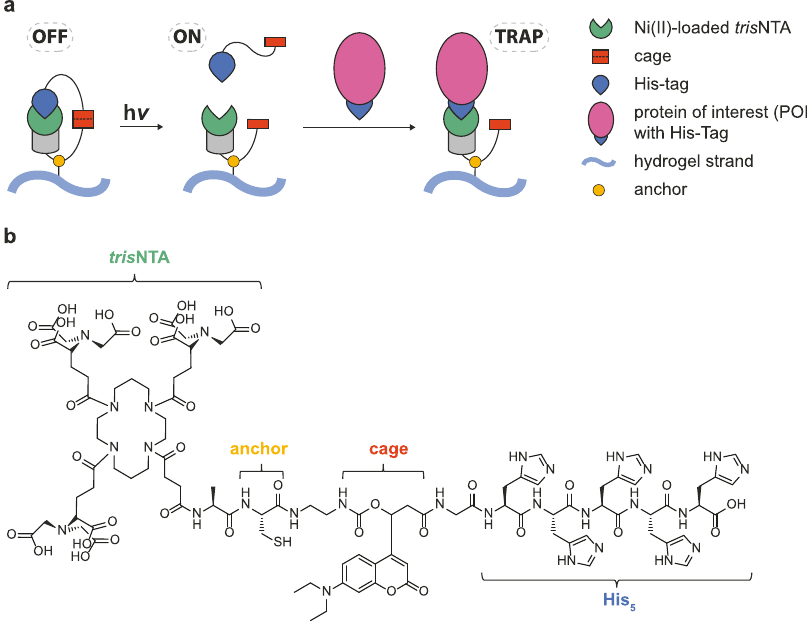
Fig. 1 Concept and chemical structure of a two-photon activatable tris NTA interaction molecule. a Schematic illustration of the autoinhibition (OFF) and light-activation (ON) of TPA- tris NTA with subsequent trapping of His-tagged POIs. b Design of TPA- tris NTA. The interaction molecule consists of the tris NTA head group and an intramolecular His C -terminus. For 2P photocleavage, a DEAC-based β -amino acid is strategically incorporated 5 -tag at the within the linker. A single cysteine is used as an anchor for hydrogel